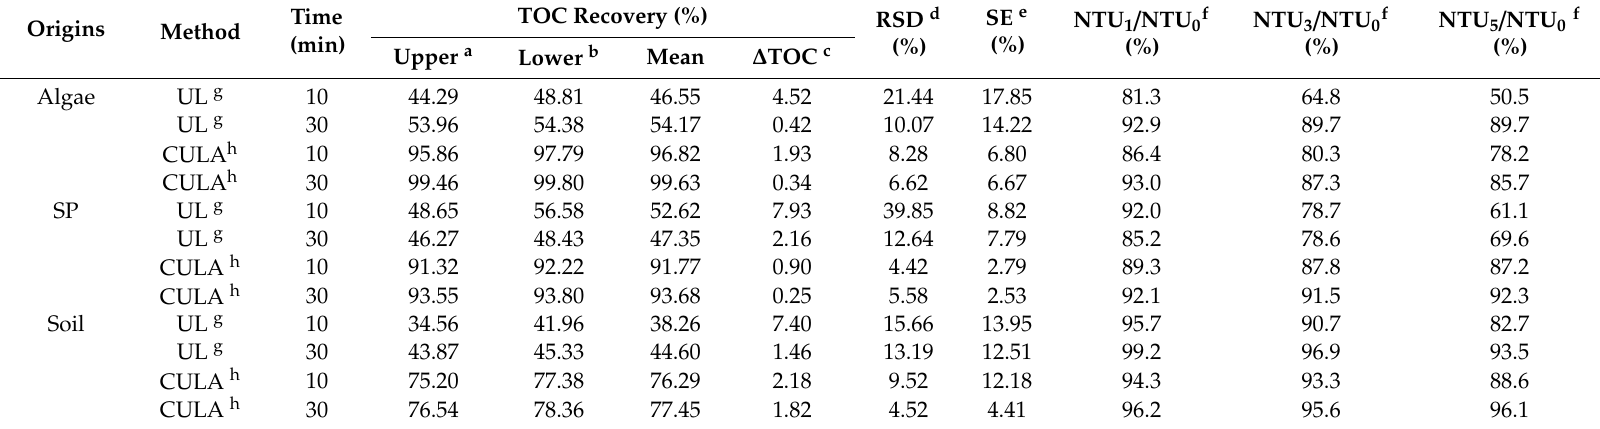
Table 3. Total organic carbon (TOC) recovery (%) and turbidity (NTU) of water samples containing suspended solids with di ff erent origins depending on the pretreatment